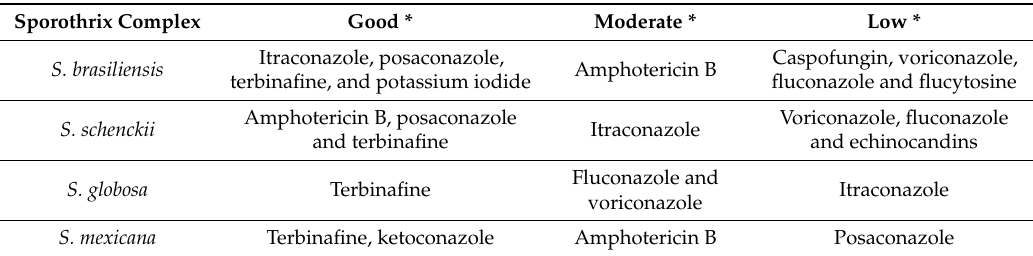
Table 2. Drugs evaluated in vitro for Sporothrix